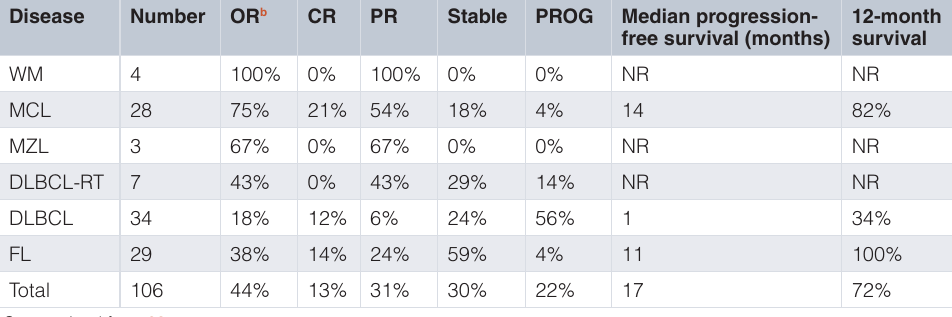
Table 1. Efficacy of venetoclax monotherapy in relapsed/refractory NHL a